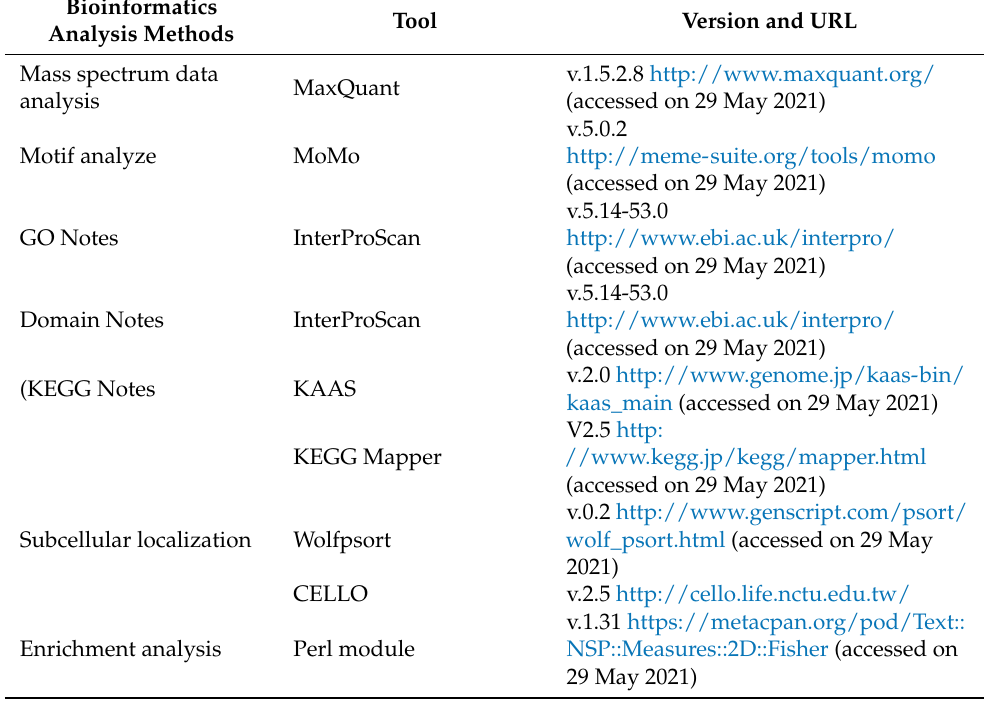
Table 2. Bioinformatics analysis